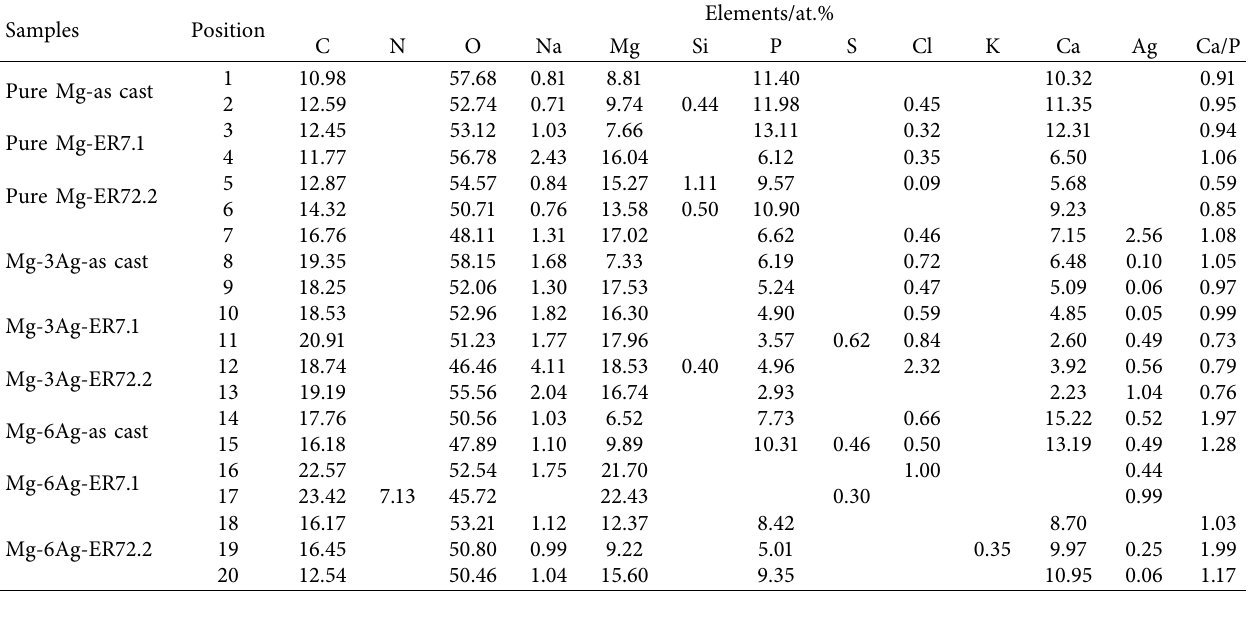
Table 4: Composition of the sample surfaces by EDS after an immersion test for 16 days. Samples